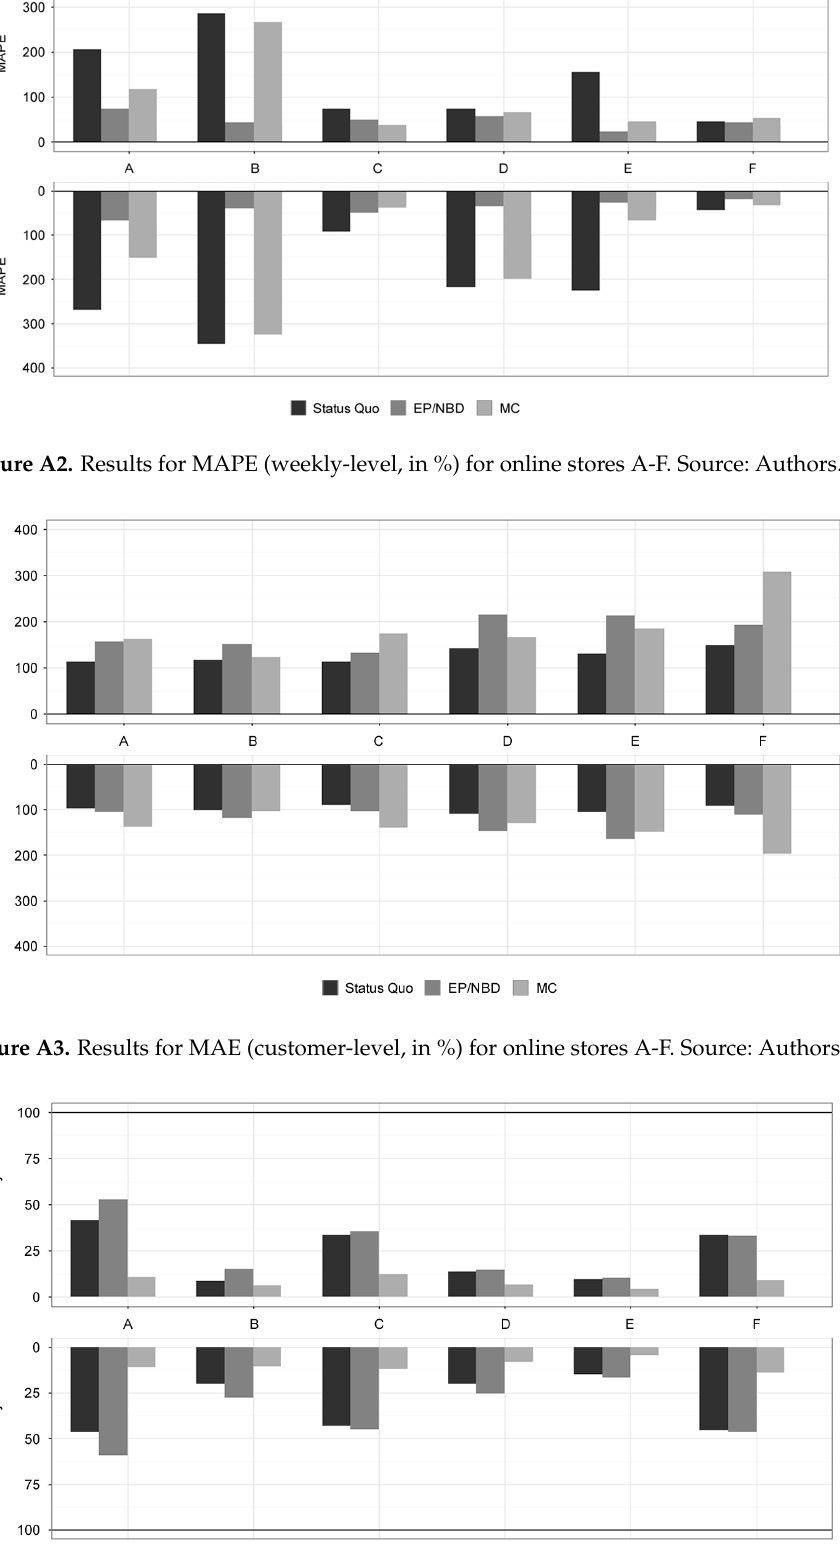
Figure A4. Results for Sensitivity (customer-level, in %) for online stores A-F. Source: Authors.